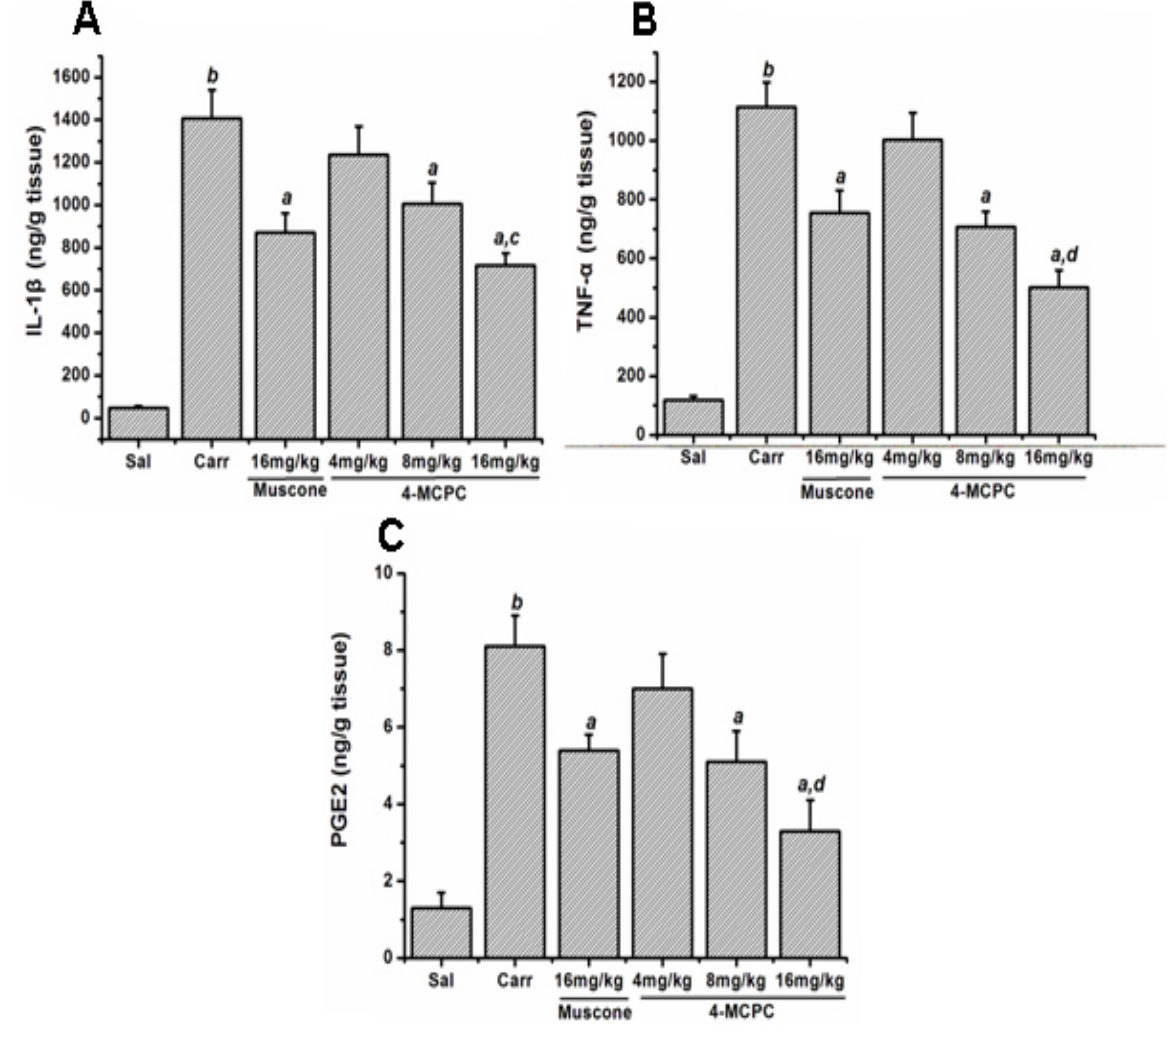
carrageenan-induced mouse paws. Treatment with 4-MCPC (8 and 16 mg/kg) and muscone (16 mg/kg), respectively, reduced IL-1β, TNF-α and PGE levels in edema paws 5 h after 2 carrageenan injection. For each group, n = 6. a p < 0.01 versus carrageenan model group; b p < 0.01 versus saline control group; c p < 0.05; d p < 0.01 versus muscone